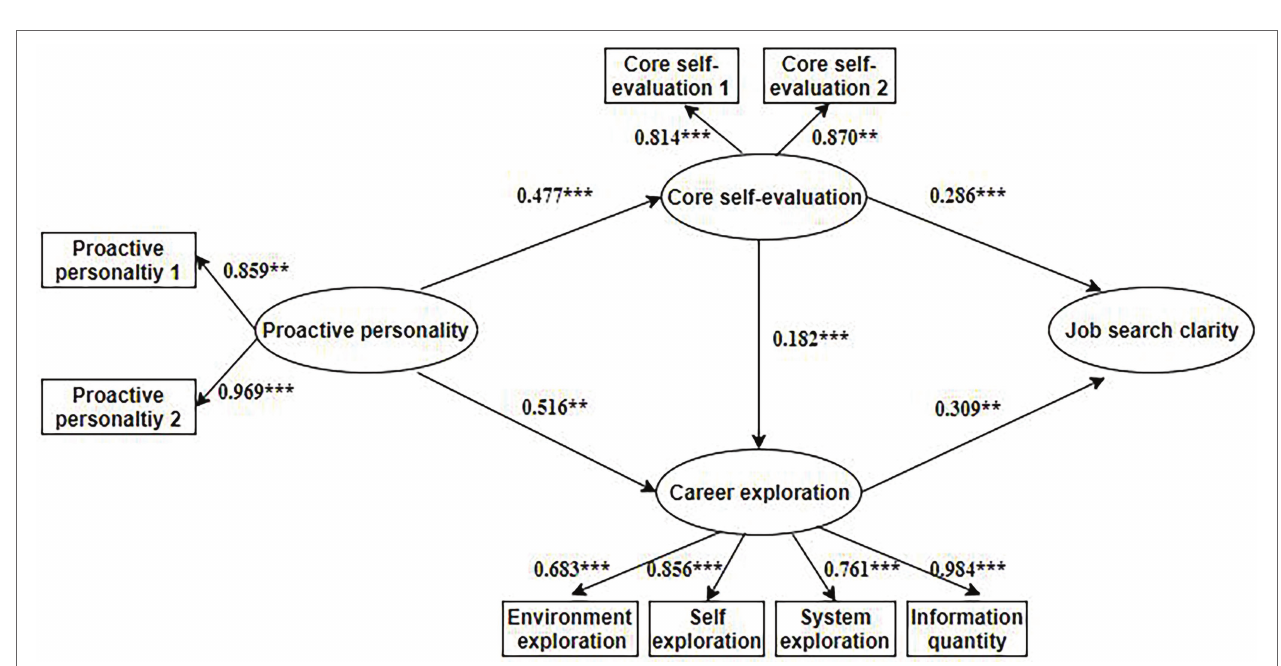
FIGURE 2 | The final model with standardized estimates ( N = 495). ** p < 0.01, *** p <